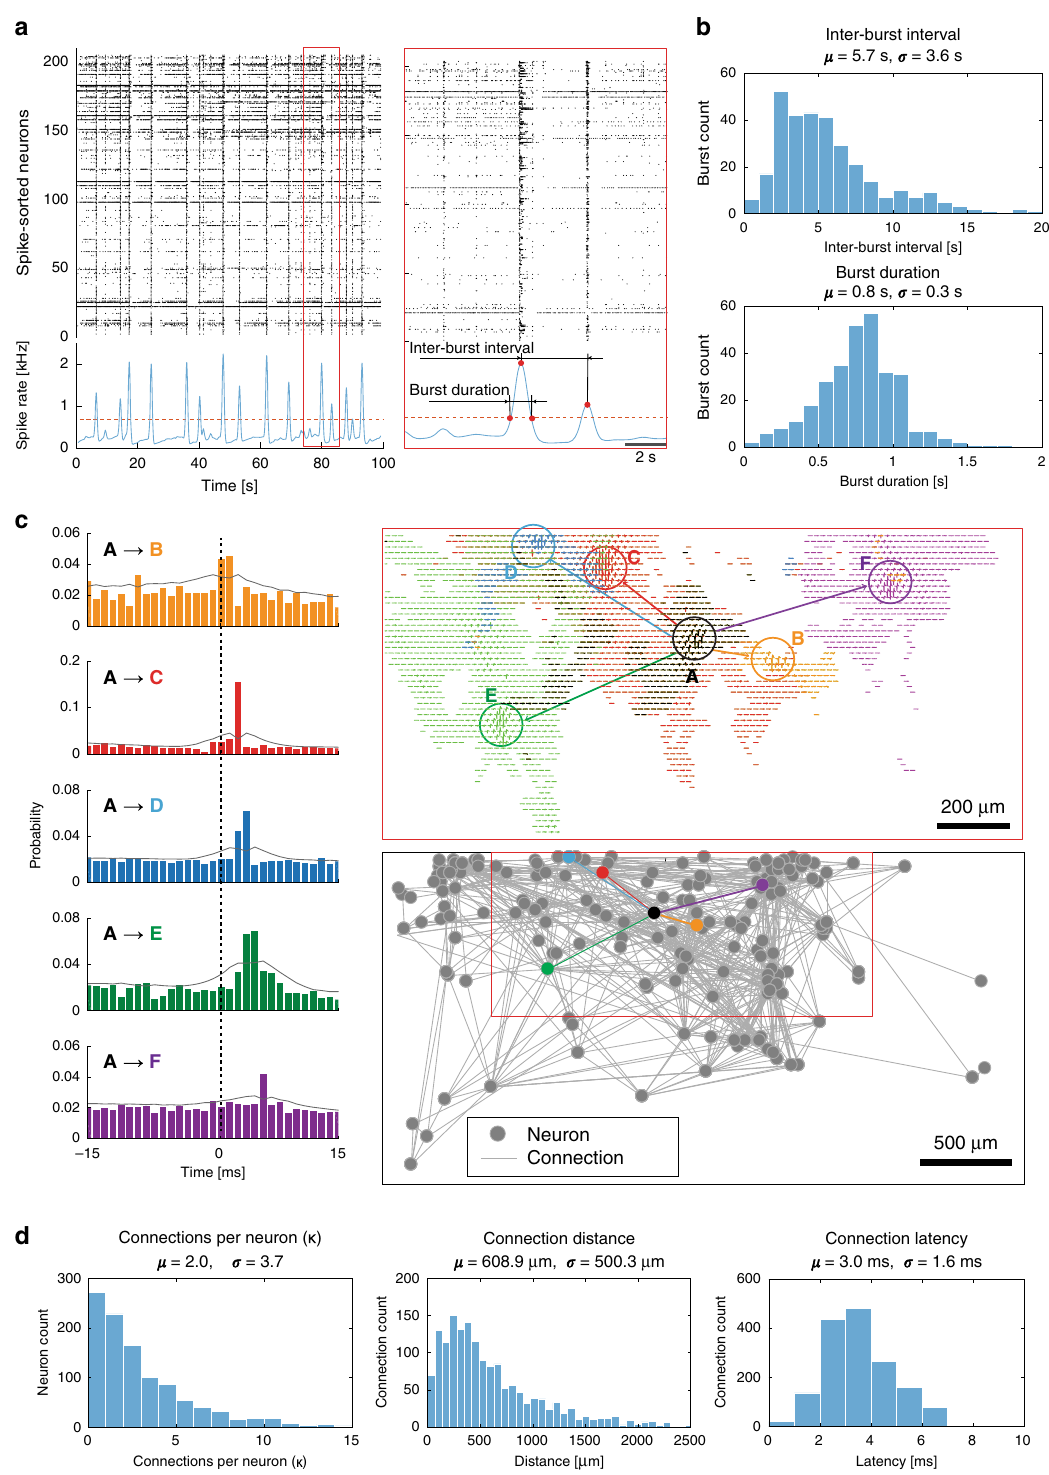
Fig. 6 Network analysis of primary-neuron cultures. a Raster plot of a burst ( n = 204 neurons from one culture at DIV 20). The detection of the burst was done by thresholding at 1.35× the baseline spike rate (after convolution using a Gaussian kernel), the de fi nition for the interburst interval and burst duration is shown in the fi gure. b Burst-related statistics have been extracted ( n = 1086 neurons, recorded from fi ve cultures at DIV 20), including interburst interval and burst duration. c Network analysis of a primary-neuron culture ( n = 204 neurons from one culture at DIV 20), including cross-correlograms and footprints of the selected connections between the black neuron A and surrounding neurons in different colors (B-F). The network-connectivity plot shows the detected connections between all neurons in the culture. d Network-related statistics have been extracted ( n = 1086 neurons, recorded from fi ve cultures at DIV 20), including the number of connections per neuron, distance, and latency for each connection. Mean values ( µ ) are given as well as standard deviations ( σ ). Source data are provided as a Source Data fi